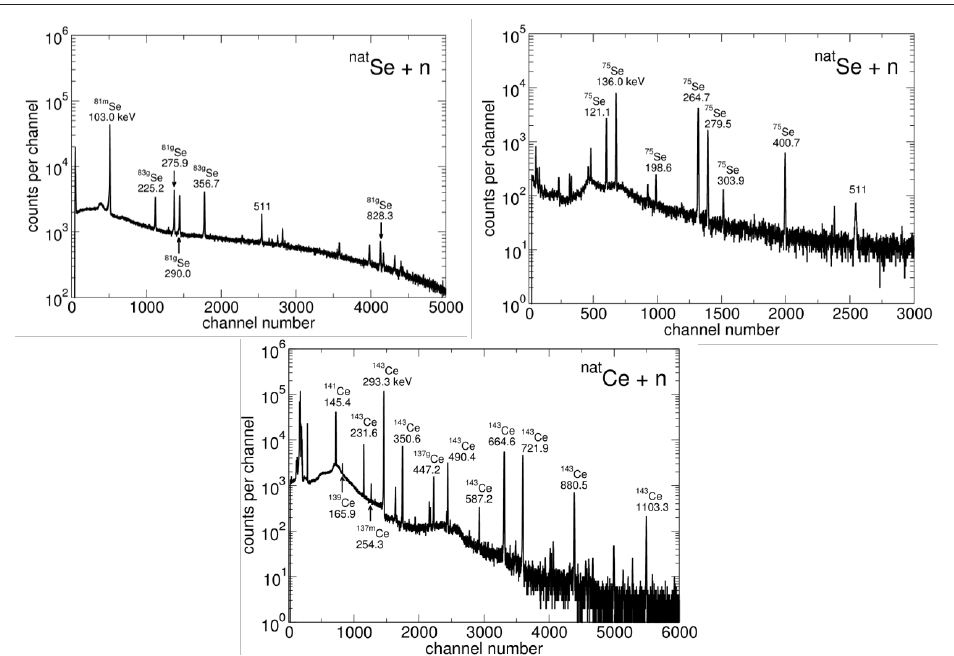
Figure 3: Gamma spectra accumulated with a shielded High-Purity Ge detector for targets of nat Se (top) and nat Ce (bottom) activated in the neutron spectrum from LiLiT. The identified lines of the respective ( n , γ ) reaction products are indicated. The top left spectrum is for the short-lived 81 , 83 Se isotopes and the top right spectrum is for the longer-lived 75 Se isotope.